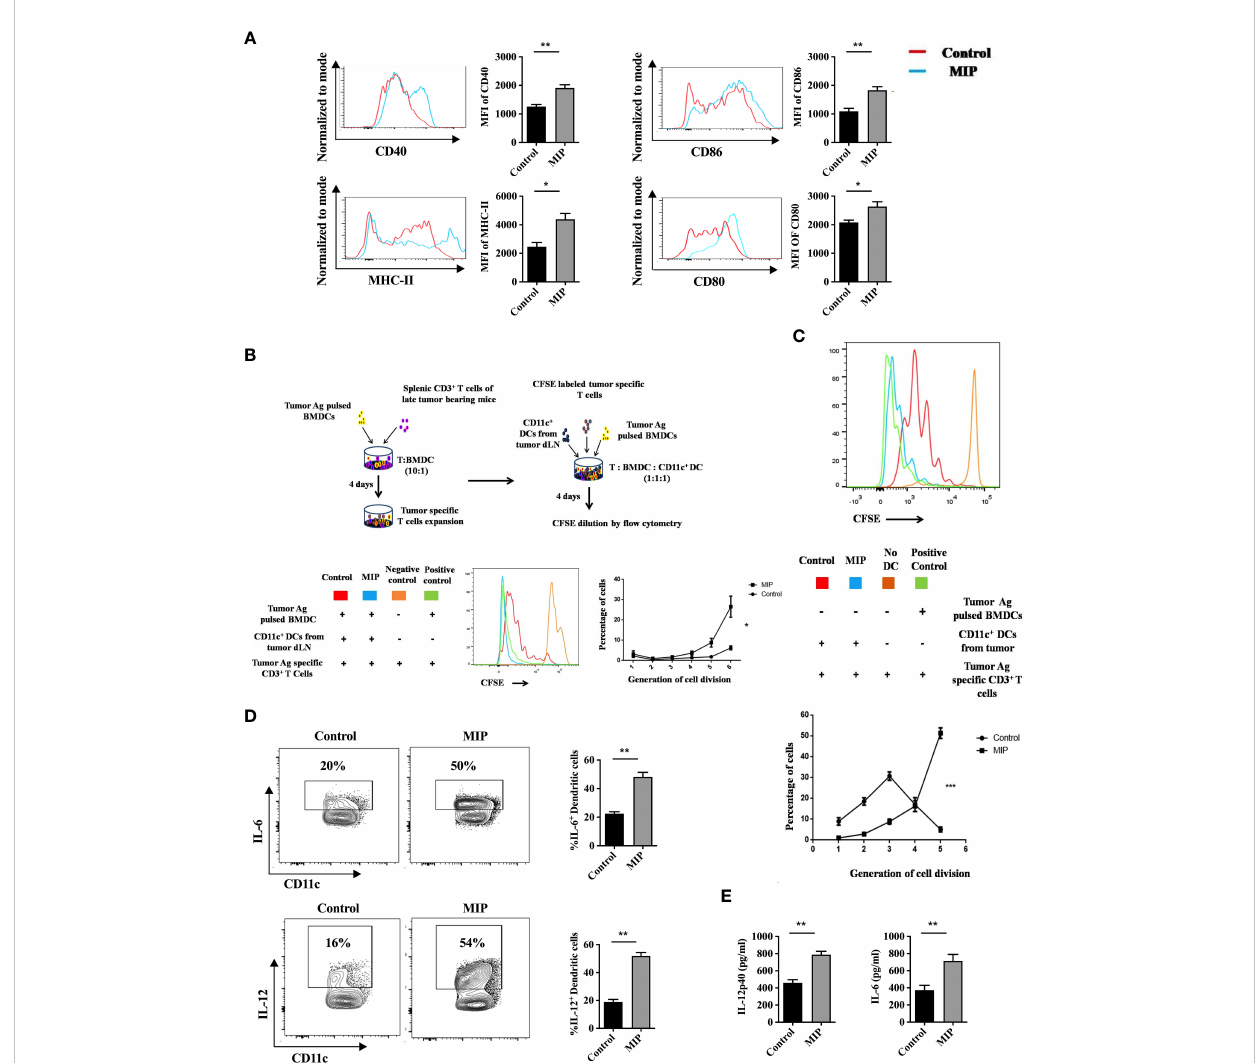
FIGURE 3 Phenotypic and functional analysis of tumor in fi ltrating CD11c + dendritic cells: (A) Flow cytometric analysis of activation and maturation markers on Ti-DCs including CD80, CD86, MHC-II and CD40. Representative histogram plots indicate MFI of each activation marker in one mouse per group (n=5). (B) Ex-vivo DC suppression assay: (Top) Tumor-speci fi c CD3 + T cells were obtained as depicted in the fl ow chart. After CFSE labeling, they were added to culture wells containing tumor pulsed BMDCs (1:1). Sorted CD11c + DCs (TI-DC) either from Control or MIP treated tumor was added to these cultures making a 1:1:1 ratio (T cell/pulsed BMDC/sorted DC). (Bottom) The histogram plot is a representative of CFSE dye dilution which indicates tumor speci fi c T cell proliferation of one mouse per group (proliferation induced by tumor pulsed BMDCs in the presence of Ti-DCs). The line graph represents percentage of tumor speci fi c T cells in each generation of cell division (n = 5 mice/group). For the line graph, statistical signi fi cance was determined by two-way ANOVA. (C) TI-DC mediated T cell proliferation assay: CFSE labeled tumor- speci fi c CD3 + T cells were co-cultured with CD11c + DCs sorted either from Control or MIP treated tumor tissue (T cell: TI-DC ~ 10: 1). The line graph represents percentage of tumor speci fi c T cells in each generation of cell division (n = 5 mice/group). For the line graph, statistical signi fi cance was determined by two-way ANOVA. (***:p=0.0001 ; *:p<0.05). (D) Single-cell suspensions from tumors were stained for CD11c, IL- 12 and IL-6; Percent frequency of IL-12 and IL-6 on Ti-DCs were evaluated by fl ow cytometry. Representative contour plot showing the frequency of IL-12 + and IL-6 + DCs in one mouse per group. (E) In a tumor antigen recall response, IL-12 and IL-6 level was determined (by ELISA) in total leukocytes from tumor draining lymph nodes of control/MIP treated mice. All fi ndings that are shown as bar graphs represent the mean ± SEM of fi ve mice per group in one experiment. Statistical signi fi cance was determined by unpaired non-parametric students t-test (*: p<0.05, **:p<0.01, ns, non-signi fi cant). For all experiments, two independent repeats were